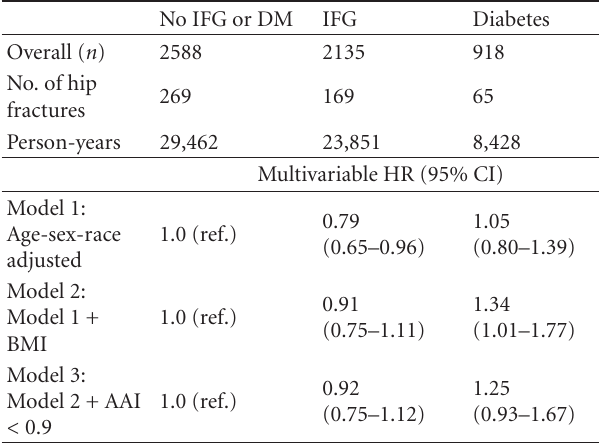
Table 2: Association of impaired fasting glucose and diabetes mellitus with incident hip fracture.